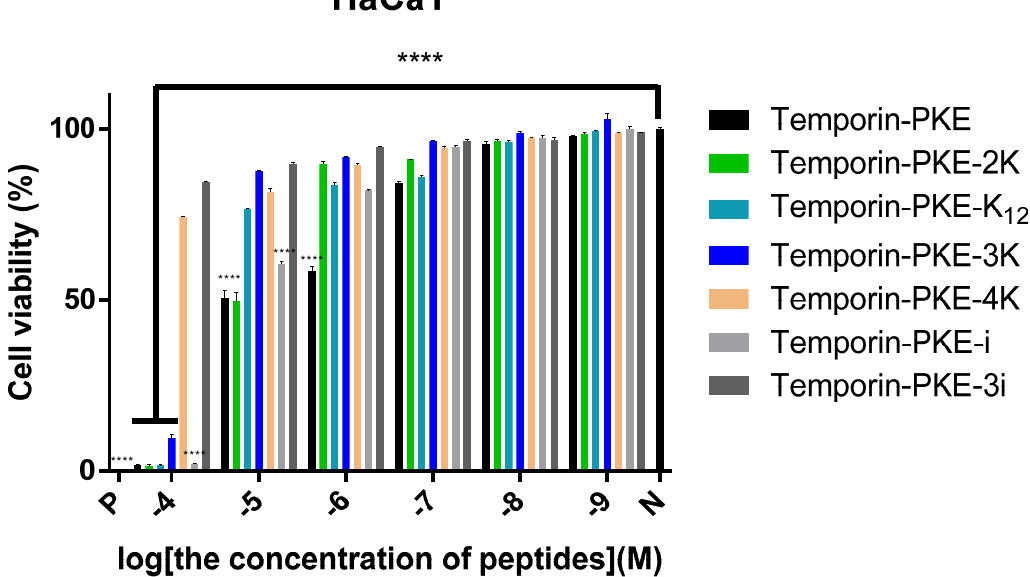
Figure 7. The cytotoxicity of temporin-PKE and its designed derivatives on HaCaT cells. N represents the negative control and P represents the positive control, which were PBS and 0.1% Triton X-100 in this experiment, respectively. The results were analysed by two-way ANOVA and Dunnett’s multiple comparisons test compared the cell viability of different concentrations of peptides with that of the negative control group. The significance is indicated by **** which indicates p < 0.0001. The error bar represents the SEM of the nine replicates from three independent tests. Table 5. The IC 50 values of temporin-PKE and its analogues against HaCaT cells. Normal Cell Lines